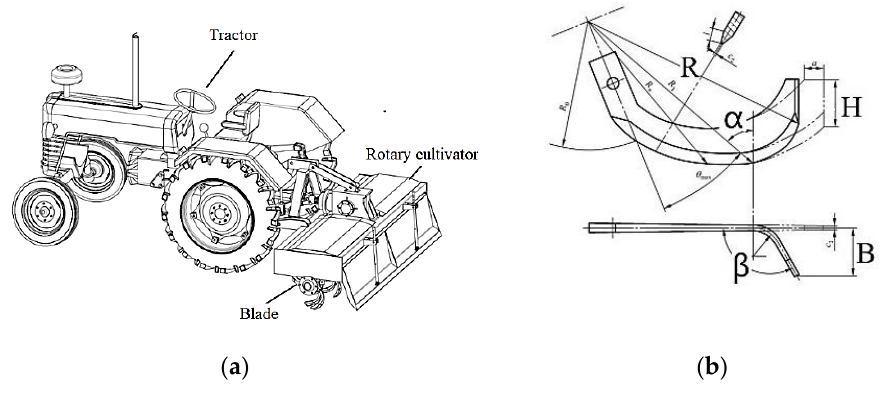
Figure 1. Standard rotary tiller structure. Table 1. The main structural parameters.